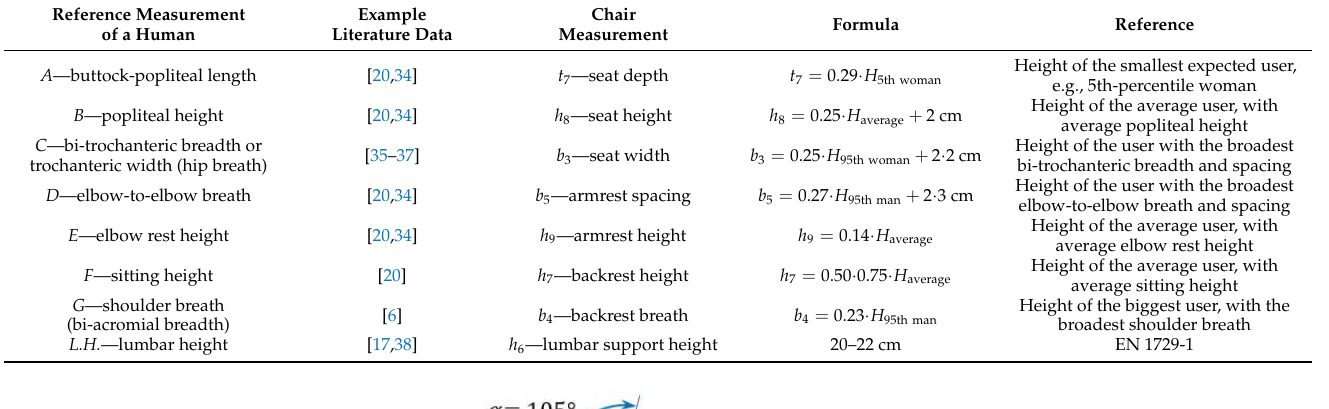
Table 2. The links between measurements of a man and measurements of a chair and proposed formulas.